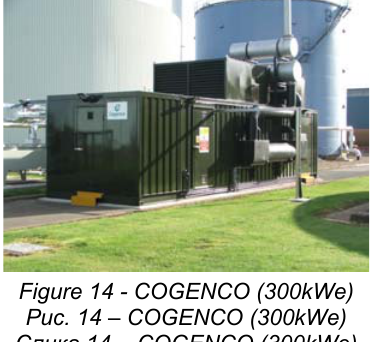
Figure 14 - COGENCO (300kWe) Рис . 14 – COGENCO (300kWe) Слика 14 – COGENCO (300kWe)